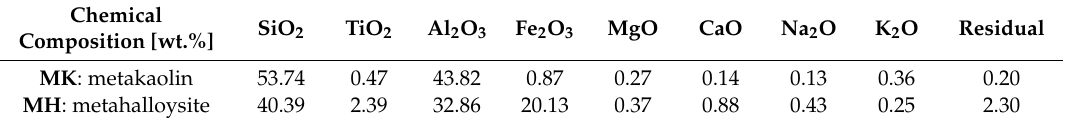
Table 2. The chemical compositions of the metakaolin and